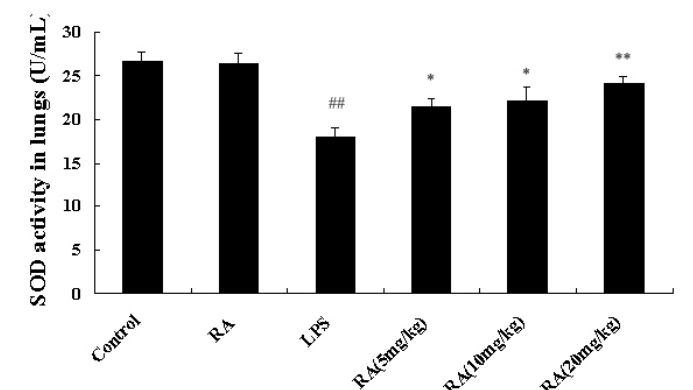
Figure 4. Effects of RA on SOD activity in BALF of LPS-induced mice. BALF was prepared from mice 24 h after LPS challenge. SOD activity was determined by SOD-specific ELISA kits.